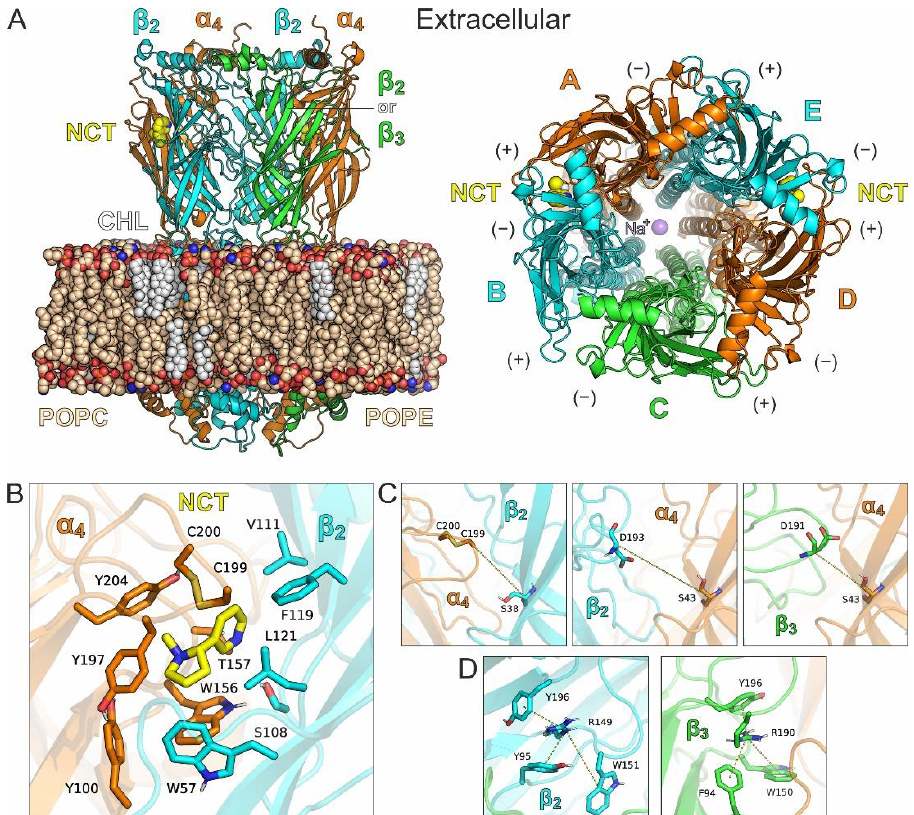
Figure 2. ( A ) Molecular representation of the two pentameric nAChR assemblies used for the MD simulations, excluding solvent and counter ions. The side view illustrates the initial placement of the receptor in a POPC/POPE/CHL lipid bilayer, where POPC = 1-palmitoyl-2-oleoylphosphatidylcholine, POPE = 1-palmitoyl-2-oleoylphosphatidylethanolamine and CHL = cholesterol. The top view from the extracellular side illustrates subunit arrangement, with α 4 subunits as chains A and D (orange), β 2 subunits as chains B and E (cyan), whereas chain C is either a β 2 or a β 3 subunit in the α 4 β 2 or the ( α 4 β 2) 2 β 3 receptor, respectively. The bound nicotine (NCT) at the two α 4(+)/ β 2(–) interfaces is shown as yellow-C spheres and the purple sphere corresponds to a structural Na + cation bound at the channel of the nAChRs. ( B ) Close-up view of the agonist-binding site at an α 4(+)/ β 2( − ) interface illustrating the packing of nicotine at the aromatic cage comprising Tyr100, Trp156, Tyr197, Tyr204 from α 4 and Trp57, Phe119 from β 2. ( C ) Definition of the loop C distance at the α 4(+)/ β 2( − ), β 2(+)/ α 4( − ) and β 3(+)/ α 4( − ) interfaces (C α –C α atoms). ( D ) Close-up view of the aromatic–cation interactions between Arg149 of the β 2 subunit and the corresponding arrangement of Arg190 in β